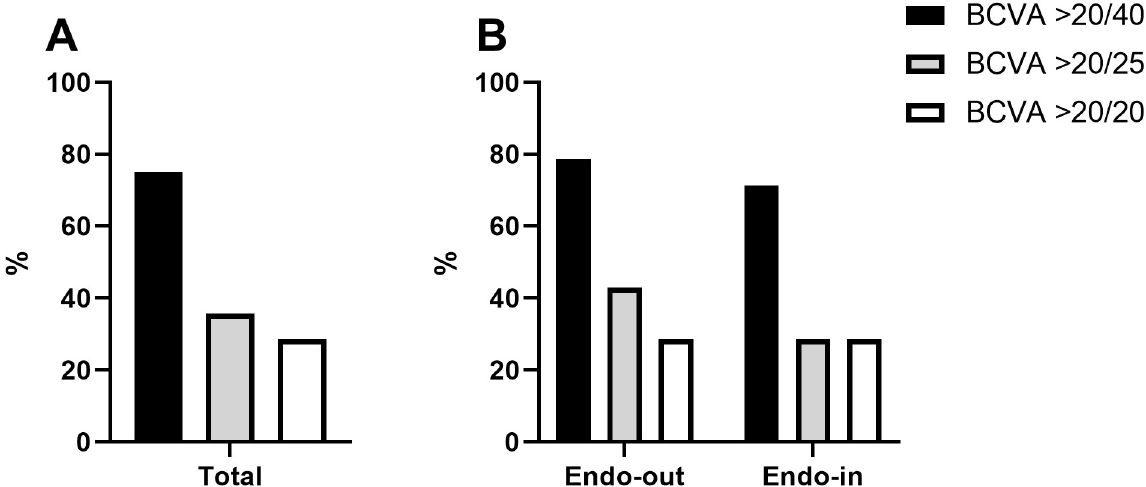
Fig 4. The proportion of eyes that achieved different levels of best spectacle-corrected visual acuity (BCVA) in Descemet membrane endothelial keratoplasty (DMEK) in all cases (A) and in between endothelium-out and endothelium-in groups (B). Percentages of eyes that achieved BCVA � 20/40, � 20/25 or � 20/20 were not different between those two